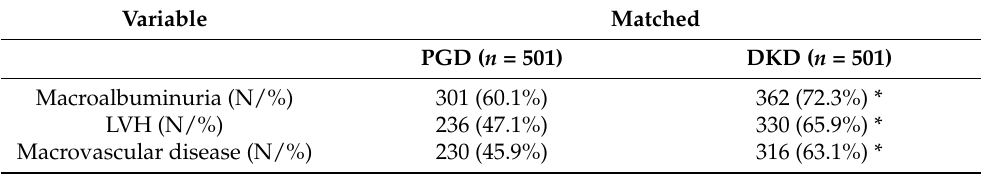
Table 2. Prevalence of target-organ damage in patients with DKD ( n = 501) and PGD ( n = 501). Variable